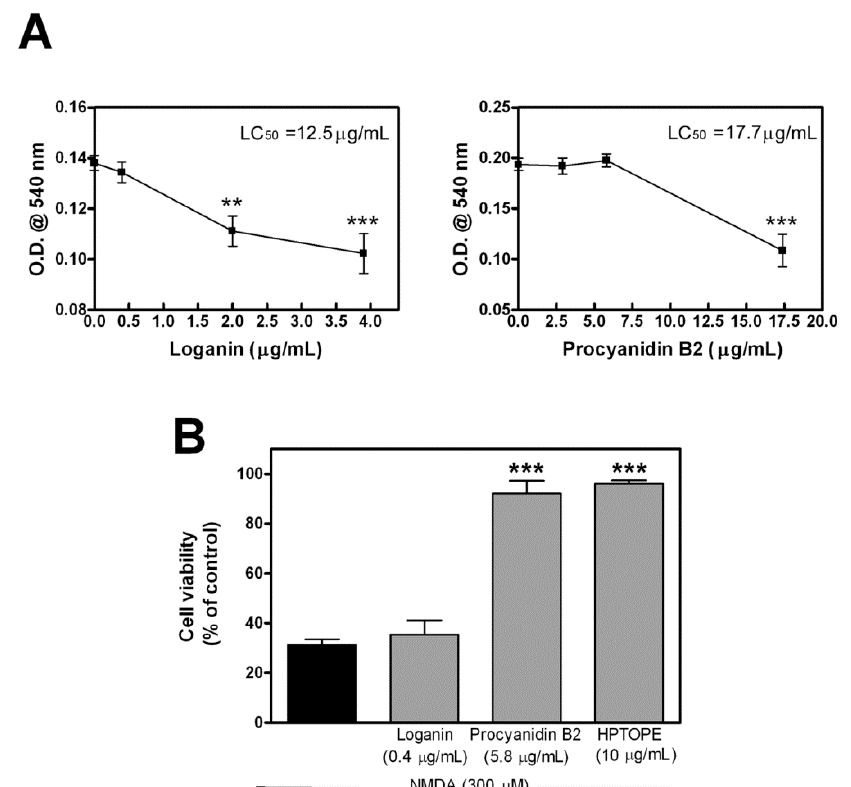
Figure 8. Cell viability of cortical neurons following NMDAR stimulation in the presence of loganin or procyanidin B2. After 14 DIV, neurons were exposed for 24 h to the indicated stimuli, and cell viability was evaluated by NRU assay. ( A ) Cell viability was evaluated following neuron exposure to increasing concentrations of both loganin and procyanidin B2. Data are means ± SEM from two experiments in triplicate. ** p < 0.01 and *** p < 0.001, according to ANOVA, followed by Tukey’s post-hoc test. LC 50 was calculated using the online free tool “Quest Graph™ LC 50 Calculator”, AAT Bioquest, Inc., 09 Sep. 2020, https://www.aatbio.com/tools/lc50-calculator. ( B ) Cell viability was evaluated following neuron exposure to NMDA in the absence or in the presence of the indicated stimuli. Data are means ± SEM from three experiments in triplicate. *** p < 0.001, according to ANOVA, followed by Tukey’s post-hoc test.